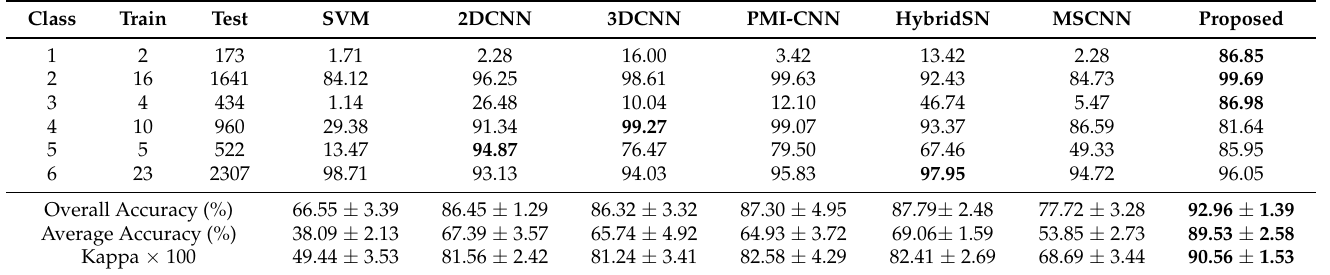
Table 9. Classification results on the GP data set with 1% labeled training samples. The best accuracy is shown in